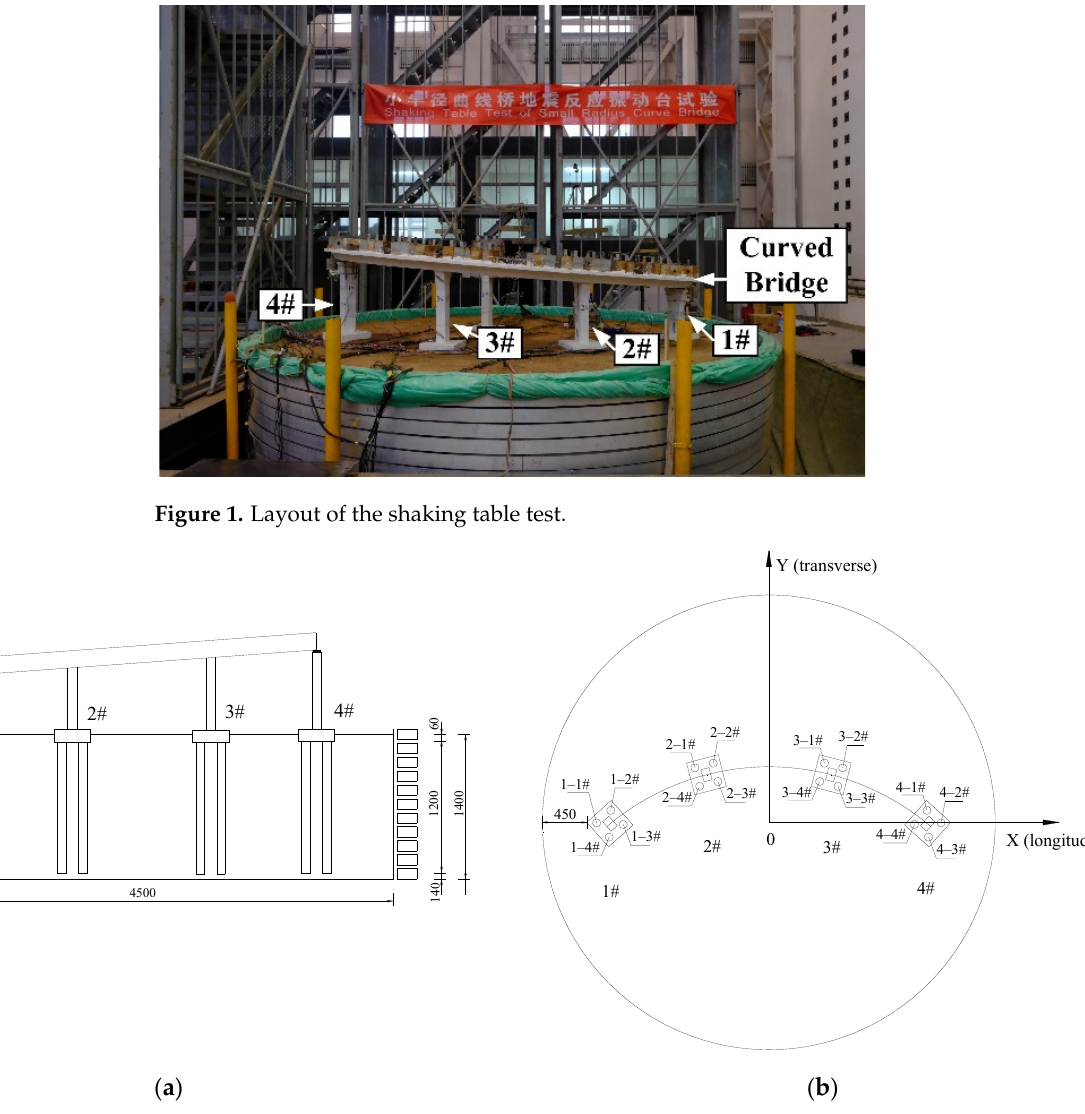
Figure 2. Layout of the test system (unit: mm): ( a ) elevation view; ( b ) plan view.